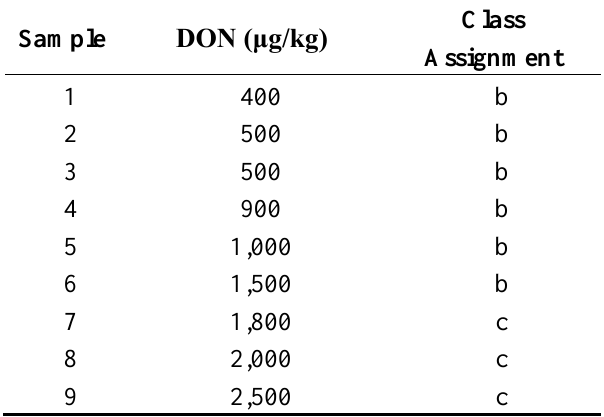
Table 2. DON contamination in wheat samples. Class Assignment (b) samples characterised by a DON level below the limit fixed by the European Commission for unprocessed durum wheat; Class Assignment (c) samples characterised by a mycotoxin level above the legal